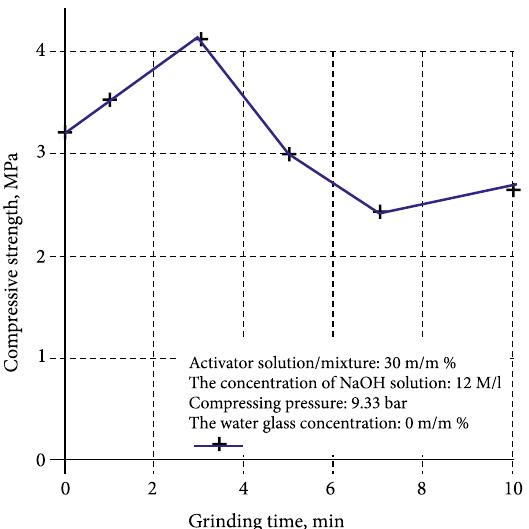
Fig. 3. Variation of compression strength as function of grinding time